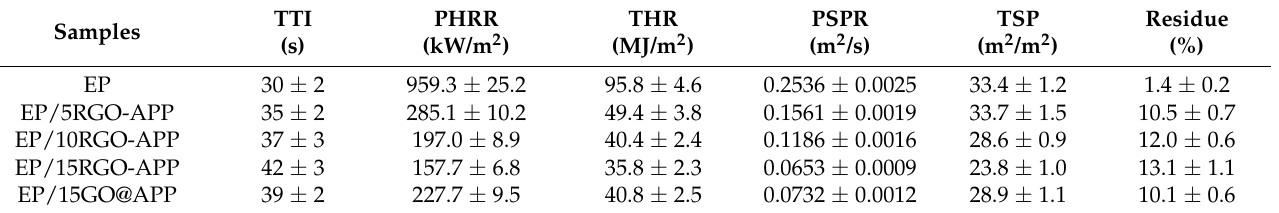
Table 3. Typical cone test data of pure EP and flame-retardant